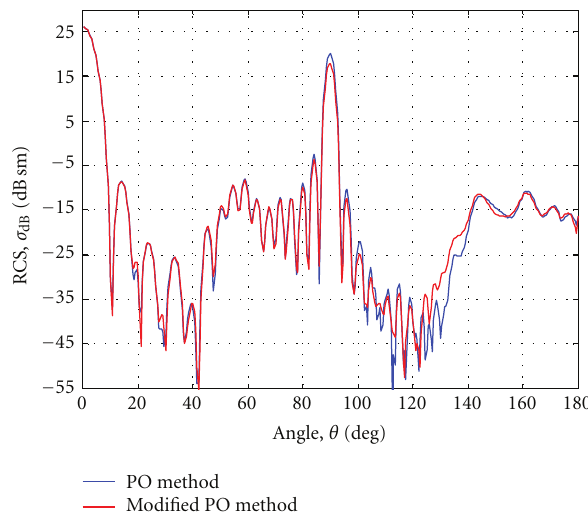
Figure 9: Monostatic RCS of the shell-shaped projectile at 10 GHz as a function of θ .